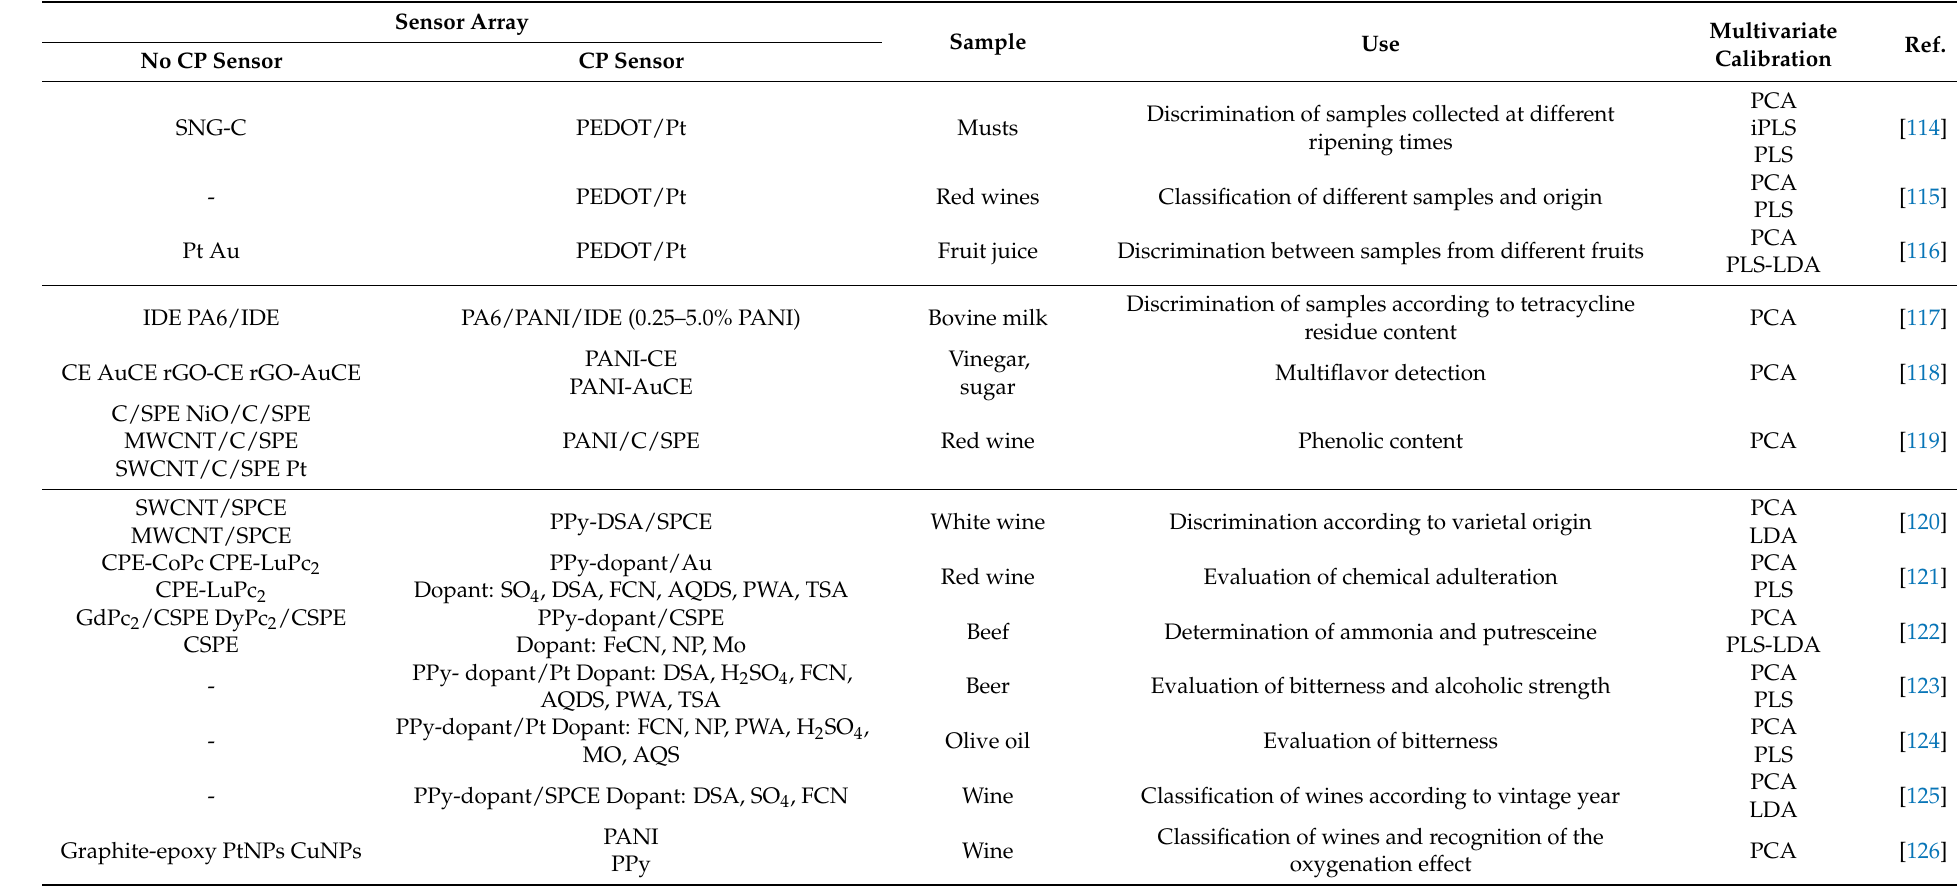
Table 2. Electronic tongues containing sensors based on conducting polymer coatings applied in the analysis of food